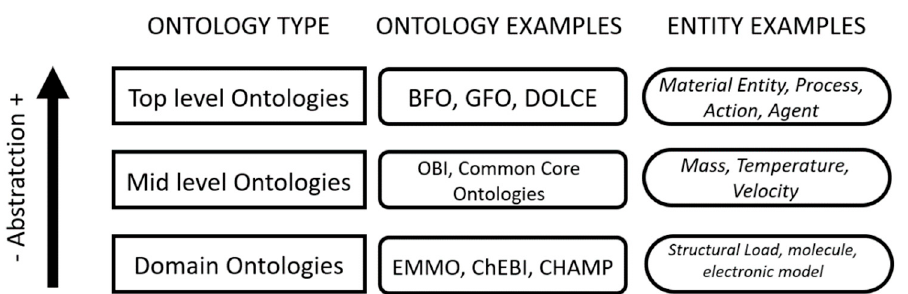
Figure 2. Ontology classification sorted by level of abstraction of the respective fields. The examples in the middle column are ontologies grouped by ontology type. The right column presents examples of entities that could be part of an ontology of the corresponding level of abstraction.